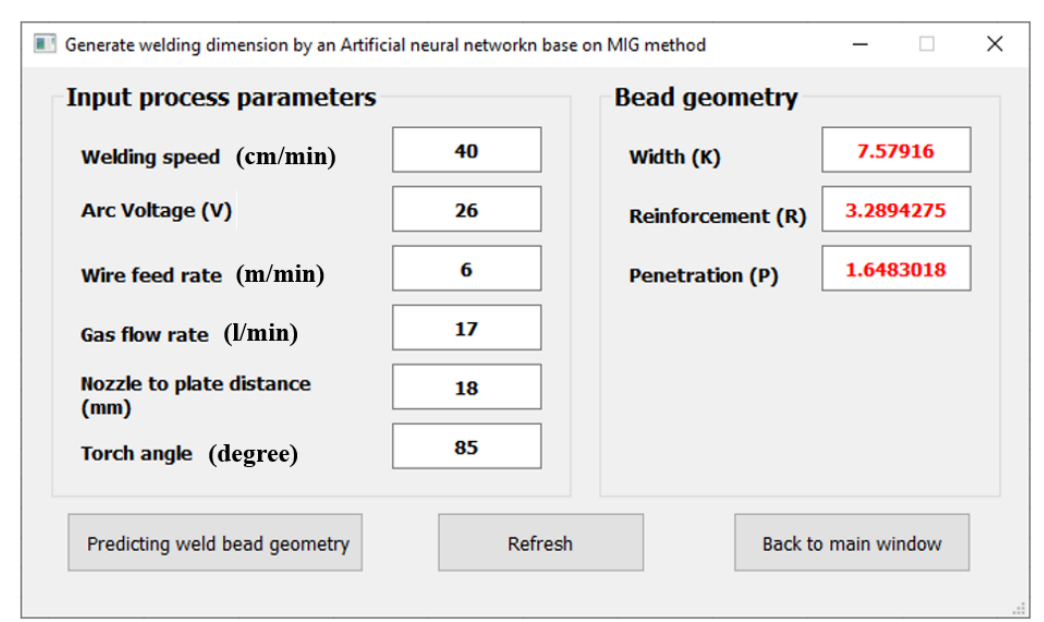
Figure 11. Screenshot of the MIG welding module of the developed predictive system.